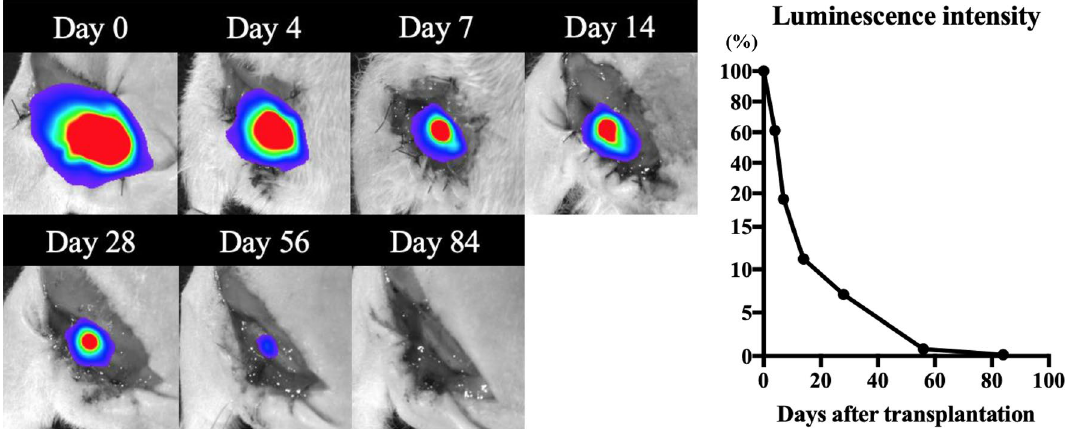
Figure 4. Images and quantitative analyses of the photon counts in the in vivo imaging system. The percentage of luminescence intensity was 61.2, 16.1, 11.2, 7.1, 0.8, and 0.2 at 4, 7, 14, 28, 56, and 84 days after implantation,